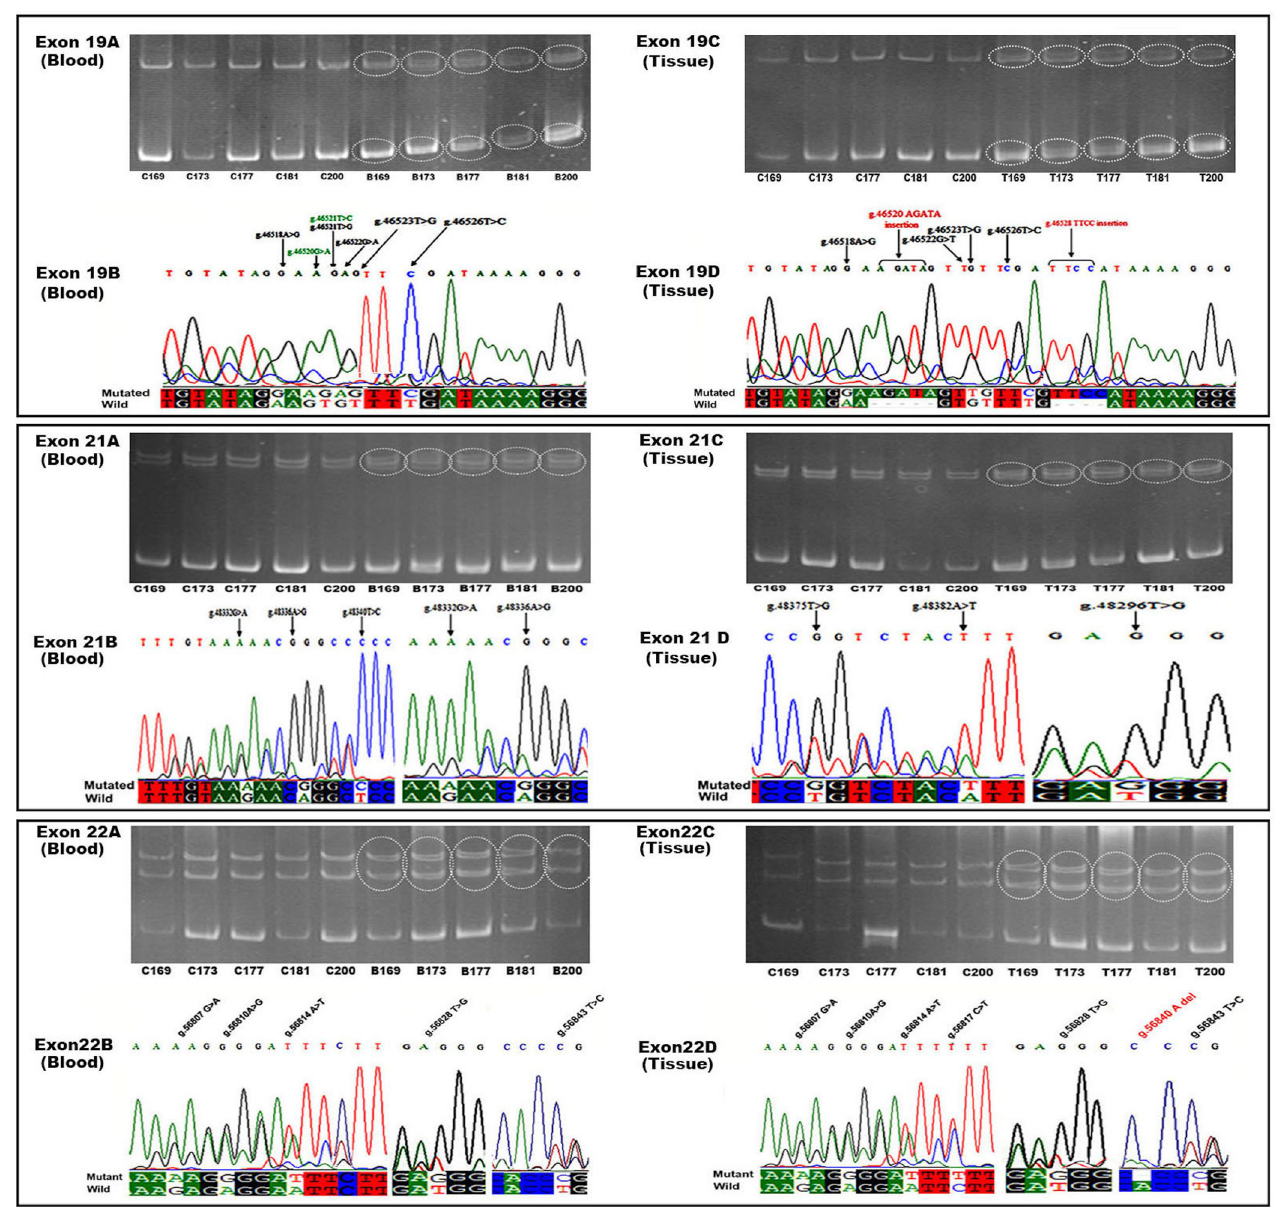
Fig 1. Mutation profiling of Exon 19–22 of Rbl2/p130 gene among breast cancer patients. Each section represents individual exon from 19–22. Panels (A) represent 10% SSCP gel high-lilting mobility shift (circles) in PCR amplicons. latter ‘C’ represents controls, whereas ‘T’ represents tissue samples. Panel (B) show the chromatogram of sequencing with arrows indicating the position of